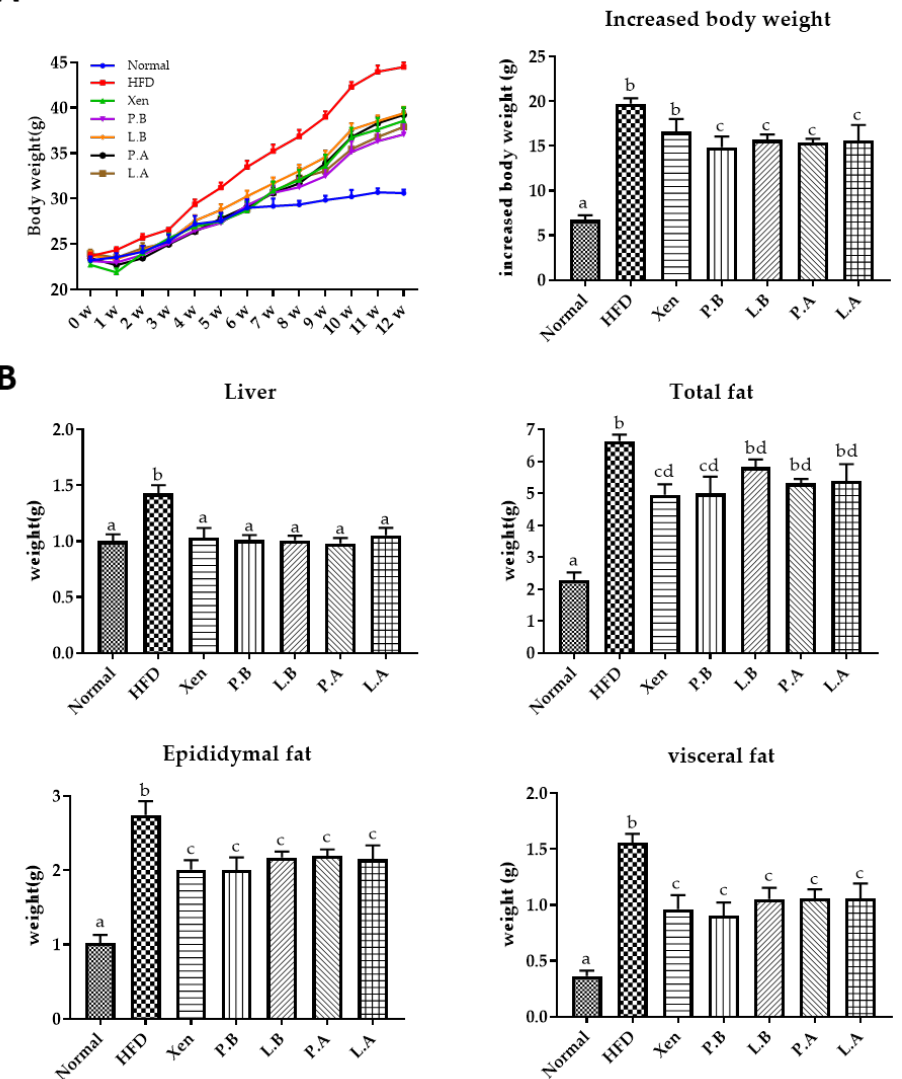
Figure 1. Effects of treatments with A. muciniphila or Xen on the ( A ) weekly body weight and body weight gain at week 12 and ( B ) weights of the liver, total fat, epididymal fat and visceral fat at week 12 in the high-fat diet-induced mice. The data are expressed as means ± SD; the differences were statistically evaluated using one-way ANOVA. Means without a common letter significantly differ, p < 0.05. HFD, high-fat diet; Xen, orlistat, P.B, pasteurized BAA-835; L.B, live BAA-835; P.A, pasteurized A. muciniphila ; L.A, live A. muciniphila .